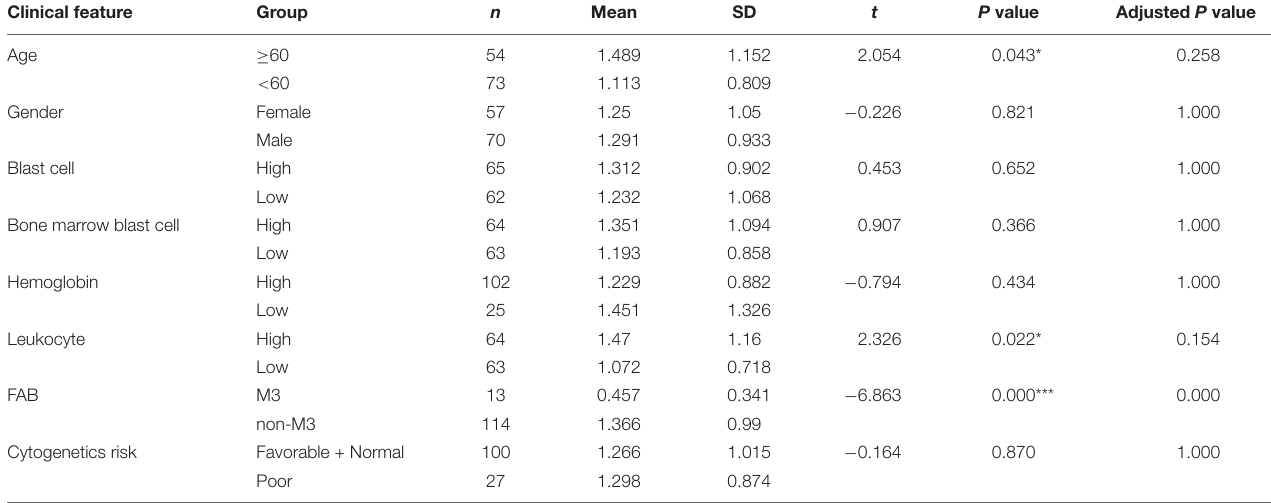
TABLE 3 | The relationship between the signature and clinical features.